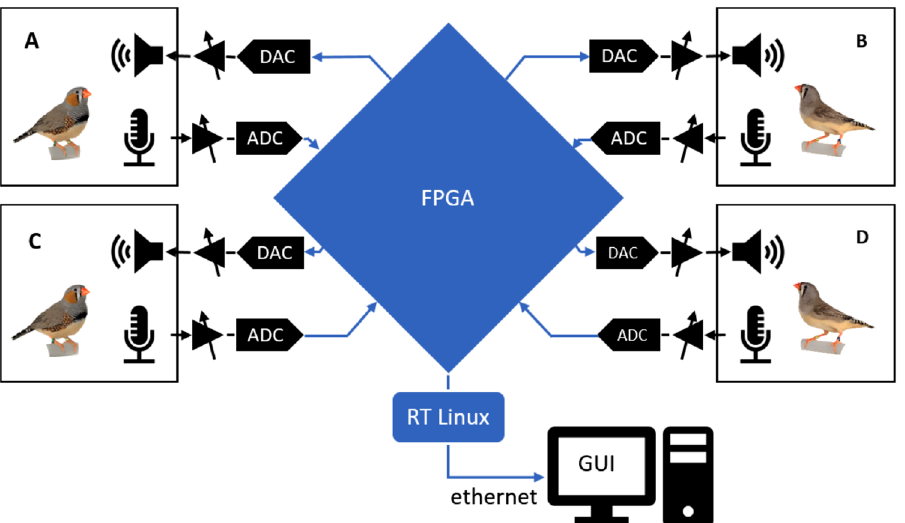
Figure 2. Overview of a 4-channel interactive communication system comprising analog (black) and digital (blue) components. Each bird A–D is kept in a separate sound isolation chamber equipped with a loudspeaker and a microphone. Microphone signals were amplified, digitized (ADC), and relayed to a single FPGA that processed the signals from all chambers. The digital output signals were converted back to analog signals (DAC) and were broadcast on loudspeakers in the